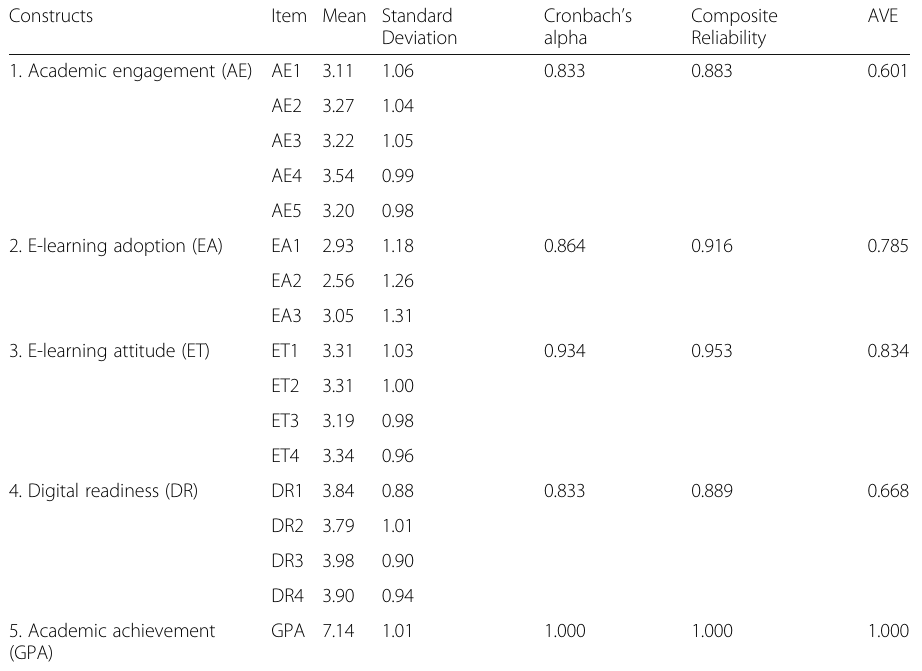
Table 2 Descriptive statistics, Cronbach ’ s alpha, composite reliability, and average variance extracted